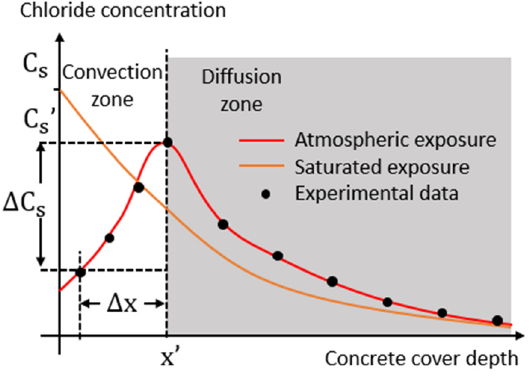
Figure 1. Chloride profiles for atmospheric and saturated exposure conditions.